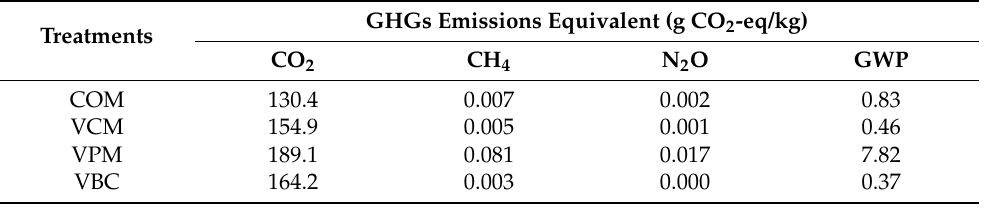
Table 3. Total greenhouse gases (GHG) emissions and global warming potential (GWP) in all